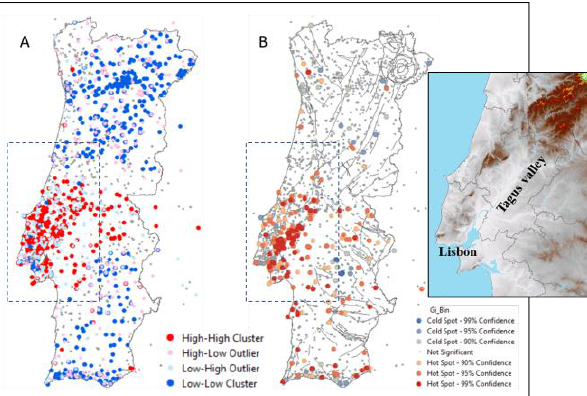
Figure 6. A. Cluster analysis using the Anselin local Moran’s I and B. hot spot analysis using Getis–Ord Gi* with a representation of the main geological faults. On the right: a Digital Elevation Model of Lisbon and Tagus valley regions, representing the same area in dashed boxes